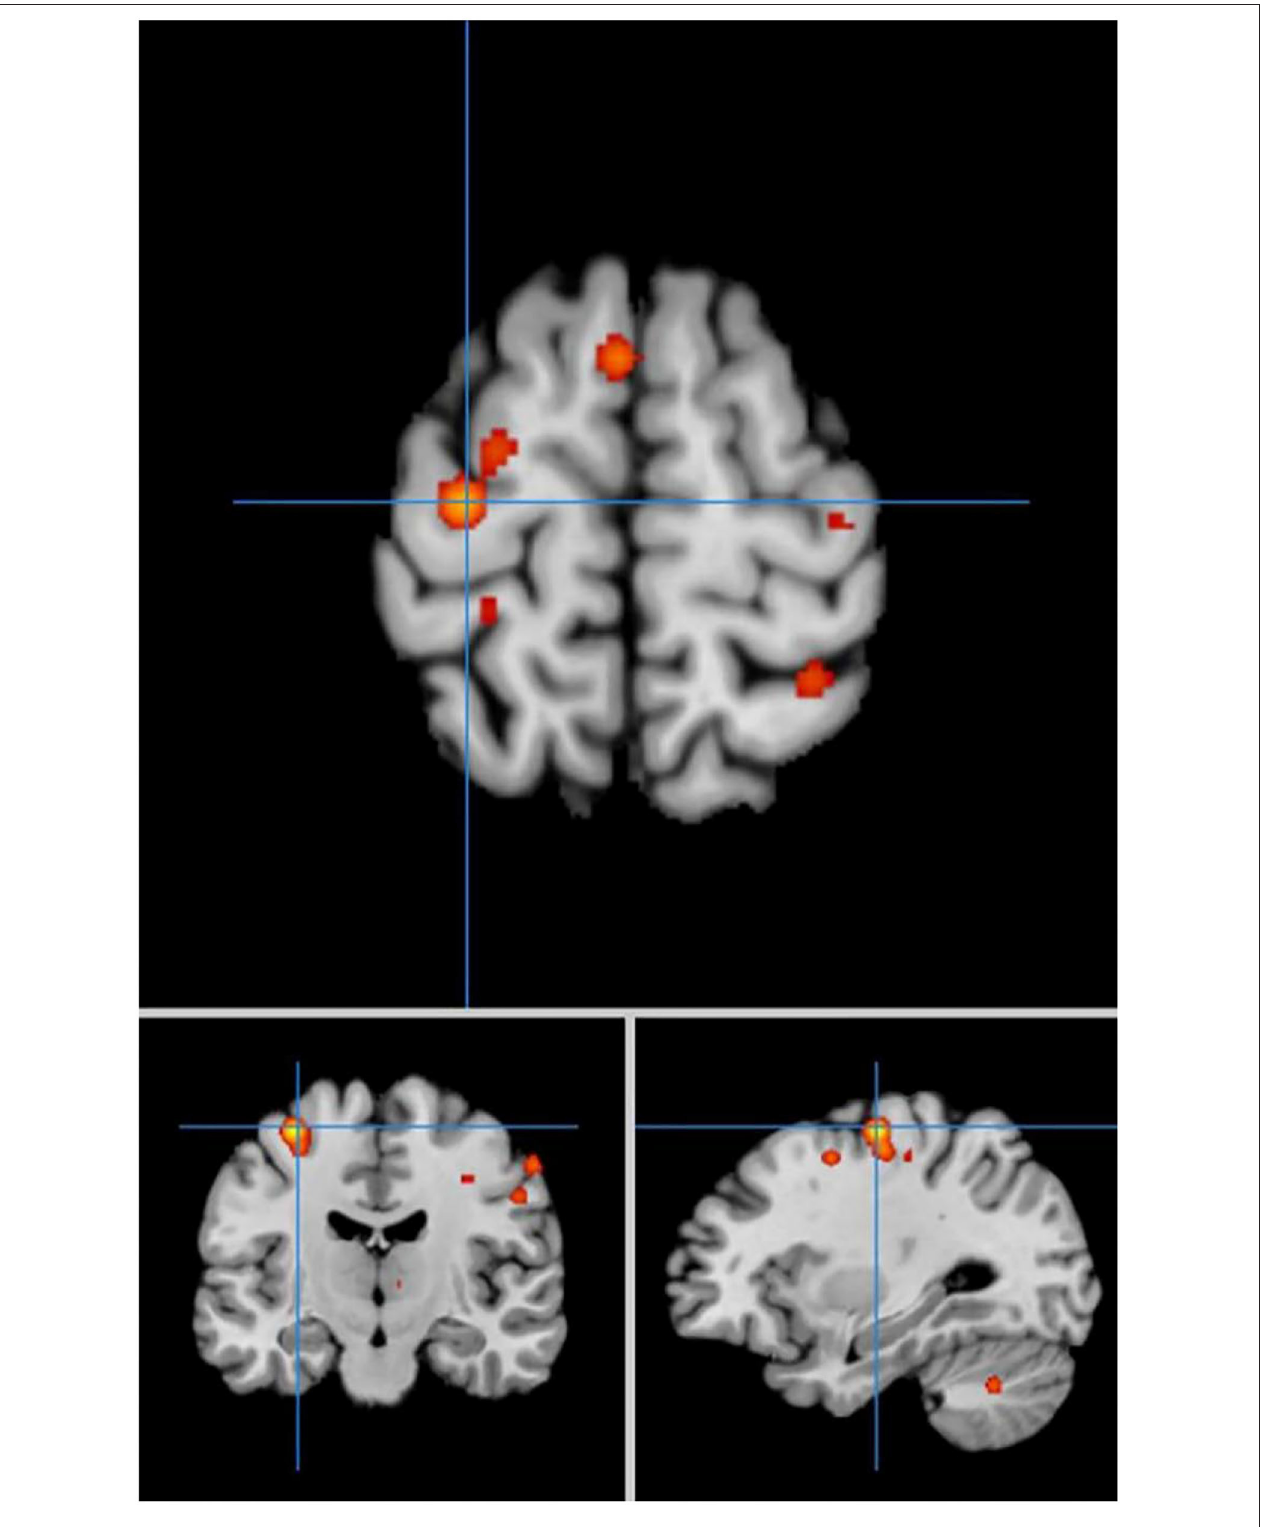
FIGURE 4 | Significant clusters with PD > HC activation in the ALE meta-analysis in self-priming conditions.